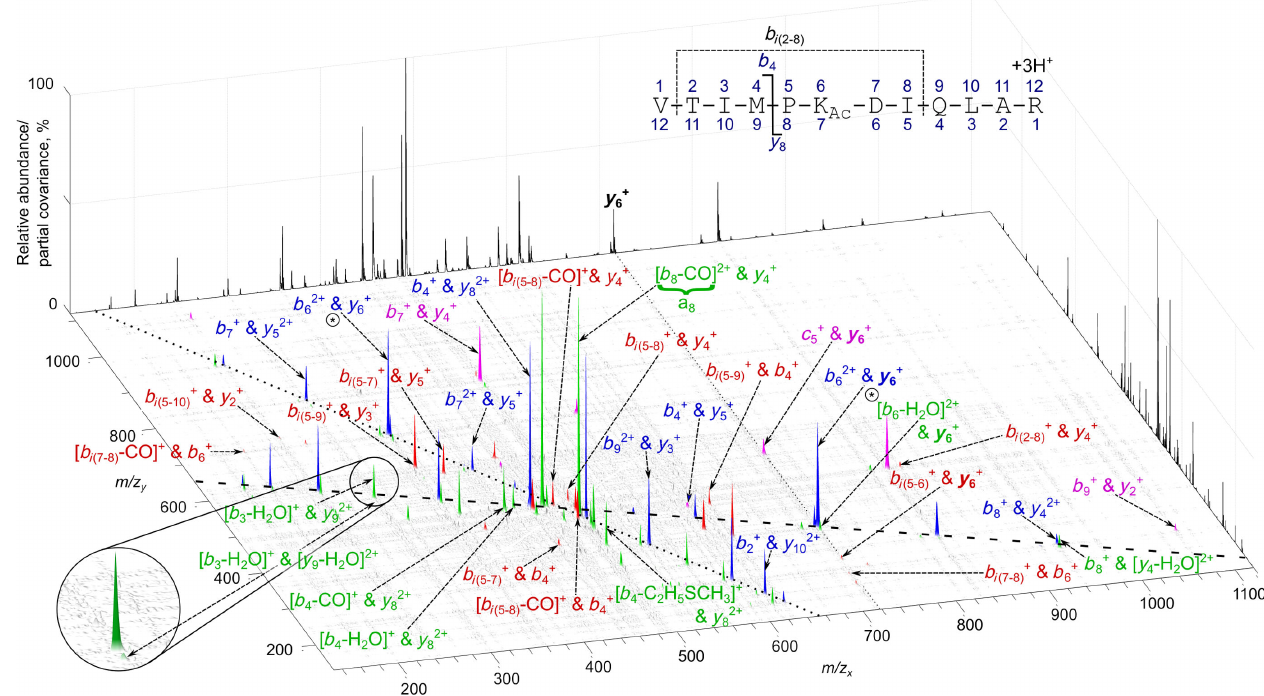
FIG. 3. Fragment-fragment correlations of the peptide ion P1 (VTIMPK DIQLAR 3 þ ) revealed on the TIC partial-covariance map. Ac The correlation signals are labeled as (X and Y) pairs of fragments corresponding to the 1D spectra plotted along the back edges of the map. The standard peptide fragment nomenclature used [37] is given in the inset. A single peak on the 1D spectrum belonging to the y þ 6 (-DIQLAR þ ) fragment is resolved into four fragment-fragment correlation peaks along the black dotted line on the map, showing four different fragmentation processes by which it is produced. Apart from the y þ 6 and b 2 þ 6 signal (marked by ⊛ ), the 2D-PC-MS peaks are annotated only on one side of the autocorrelation diagonal for clarity. The blue dotted and dashed mass conservation lines follow correlations (blue peaks) where a single bond breaks in the chain of 12 amino acids of the parent ion. Green correlations mark a loss of small neutral molecules (e.g., water) in the fragmentation process. The red and magenta correlations reveal processes where more than one peptide bond is broken. The map provides much more information on the fragmentation mechanisms and for identifying the parent peptide than the 1D spectrum. Selected correlation signal annotations using single-letter amino acid code [35] are shown in Fig. S2 in the Supplemental Material